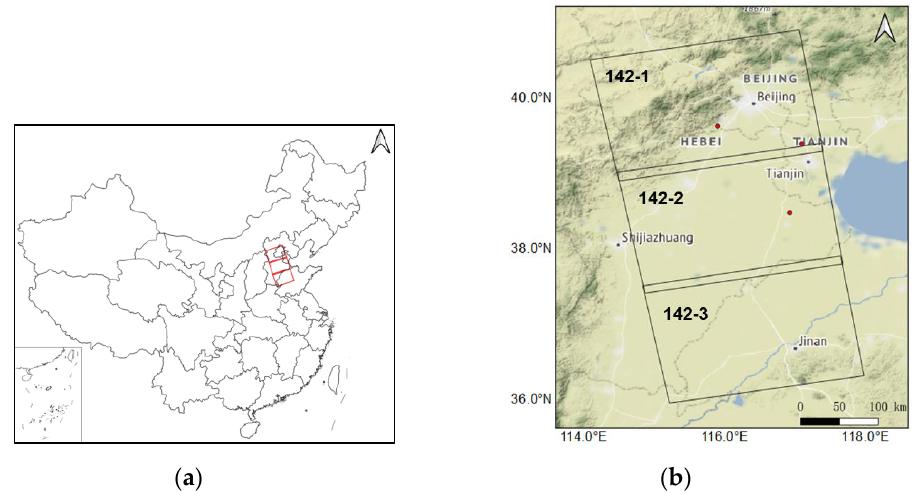
Figure 8. ( a ) The locations of the study regions on the China map are shown in red boxes; ( b ) the outlines of Sentinel-1 frames for track 142 are shown in the black boxes, superimposed on the topography image, and the red dots are the GNSS stations of the China Earthquake Administration.